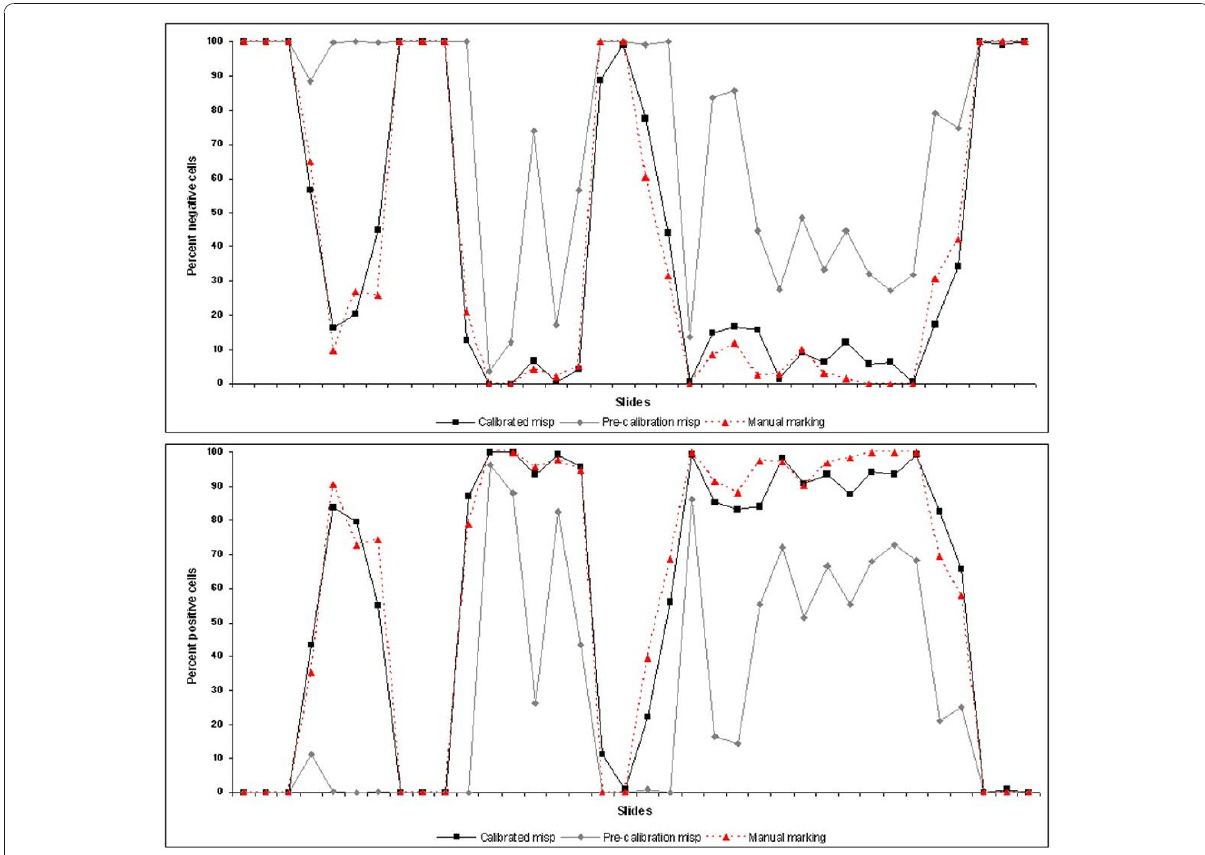
Figure 2 Agreement in cell detection between the un-calibrated and calibrated algorithm and the manual encircling .